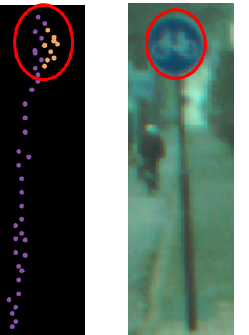
Figure 6. The point cloud of traffic sign (the left) and street view (the